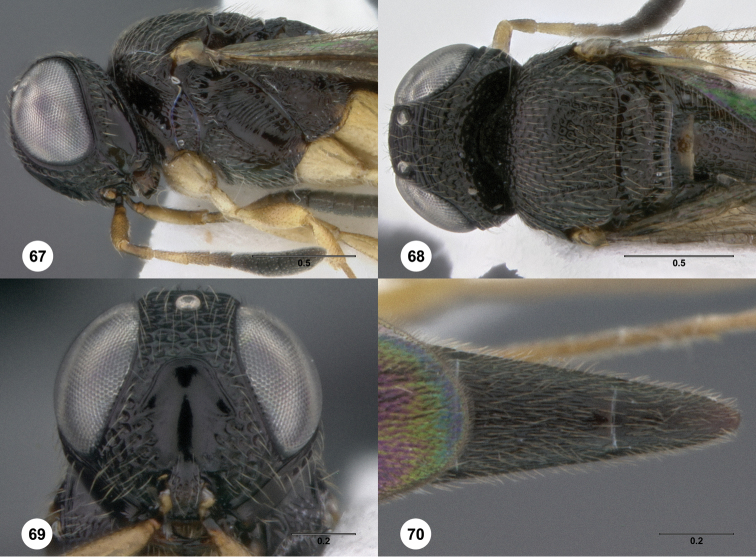
Oxyscelio corrugationis sp. n., female (OSUC 368229) 67 Head and mesosoma, lateral view 68 Head and mesosoma, dorsal view 69 Head, anterior view 70 Metasoma, dorsal view. Morphbank40